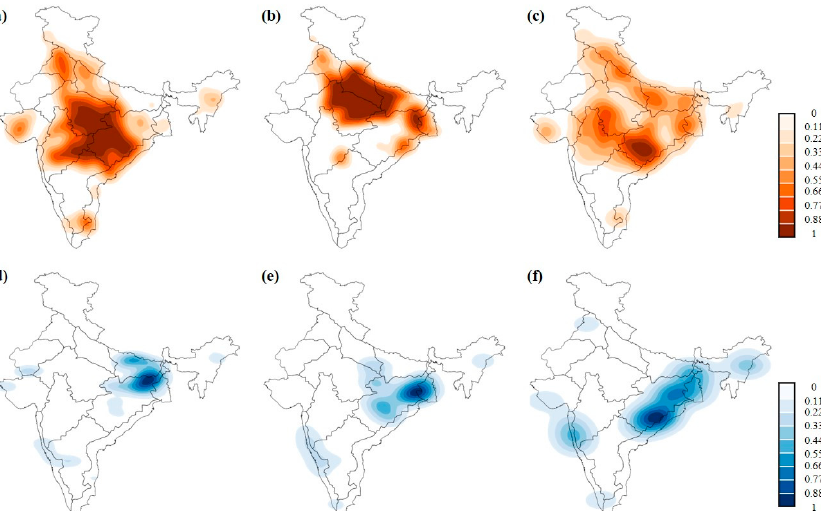
Figure 8. Regions showing statistically significant composite anomalies of soil moisture (m 3 /m 3 ) across India during the month of June when SST anomalies of the Western Indian Ocean ( a , d ), Northern Indian Ocean ( b , e ) and Central Indian Ocean ( c , f ) demonstrated positive (upper) and negative (lower) variations. The colour bar shows the scaled density estimate of negative (orange) and positive (blue) soil moisture anomalies. The warmer SST in the oceanic regions leads to negative soil moisture anomalies, while the colder SST leads to positive soil moisture anomalies in the shaded areas.